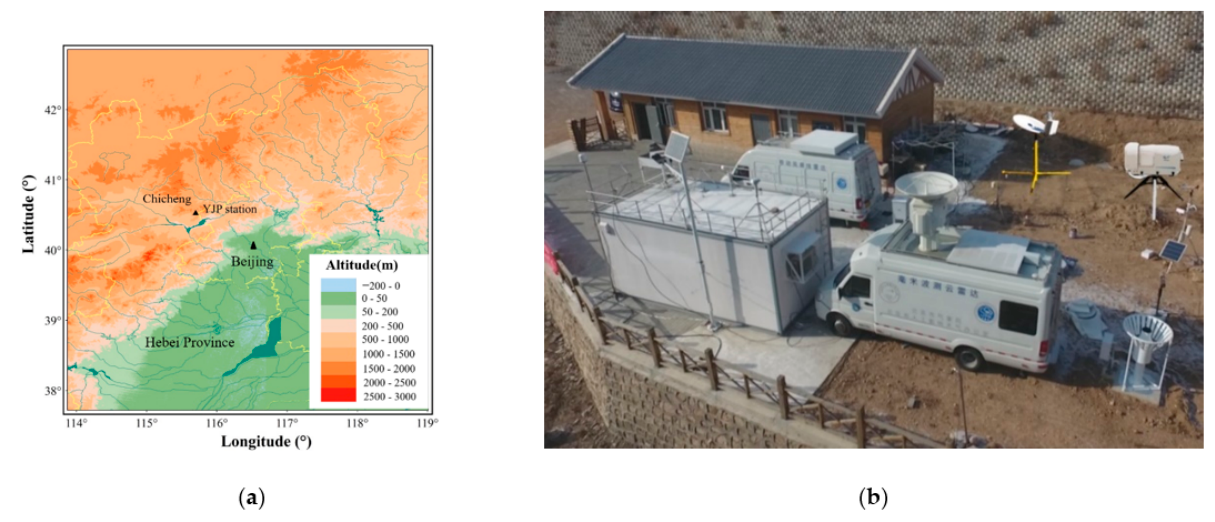
Figure 1. Location ( a ) and equipment layout ( b ) of YJP Station in the Haituo Mountain District of